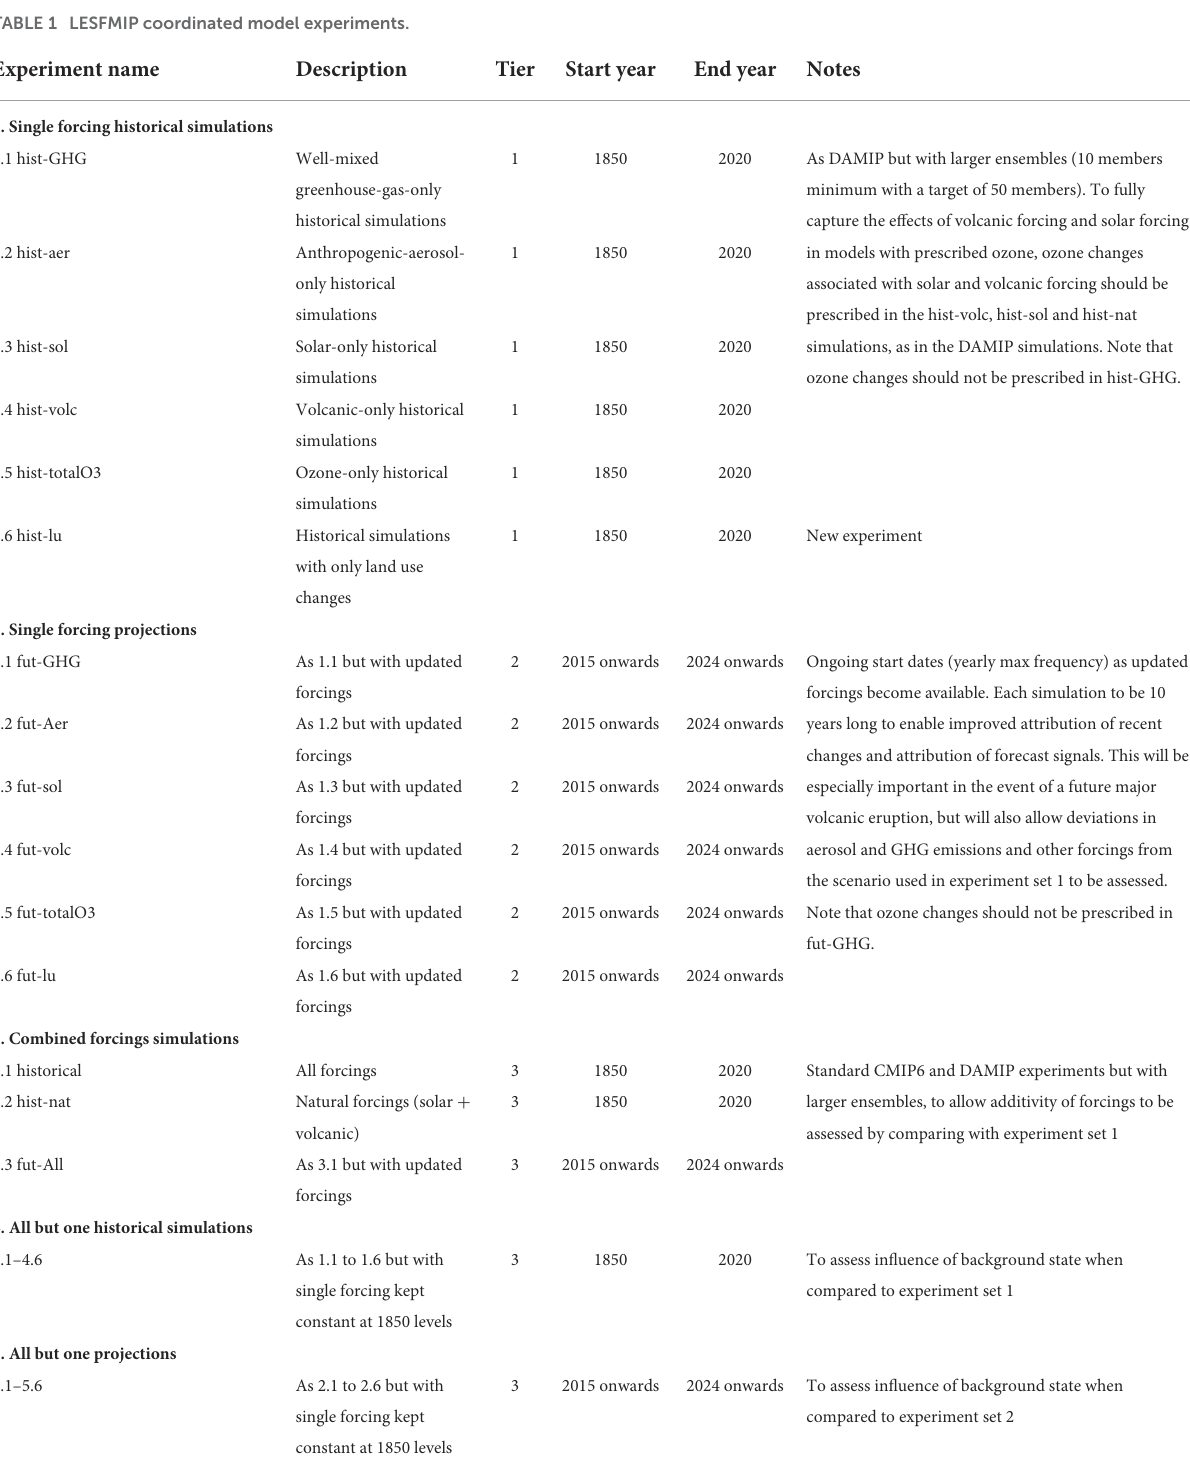
TABLE 1 LESFMIP coordinated model